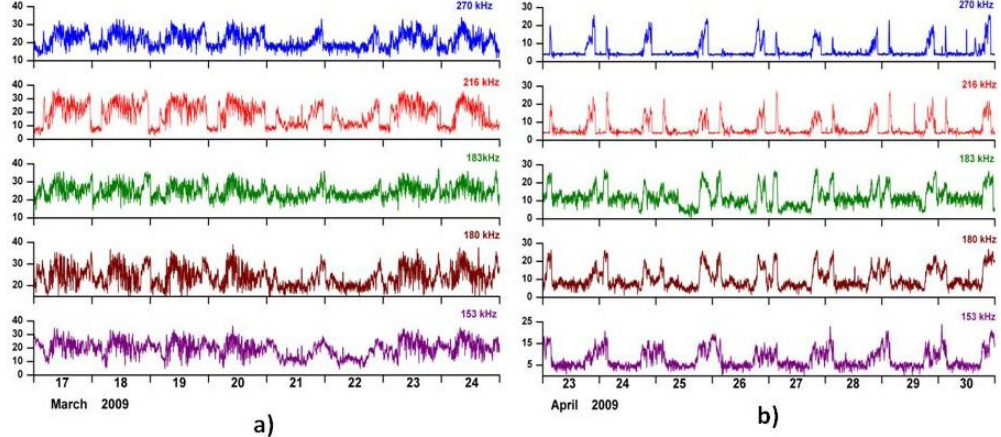
Fig. 3. (a) Trend of the intensity of five LF radio signals sampled in Bari (southern Italy) during a period of eight days. The noise appears reduced on 21–22 March, corresponding to Saturday and Sunday. (b) Trend of the intensity of the same radio signals sampled in Torre Canne (southern Italy) during a period of eight days. A low level of noise is evident in each trend during all